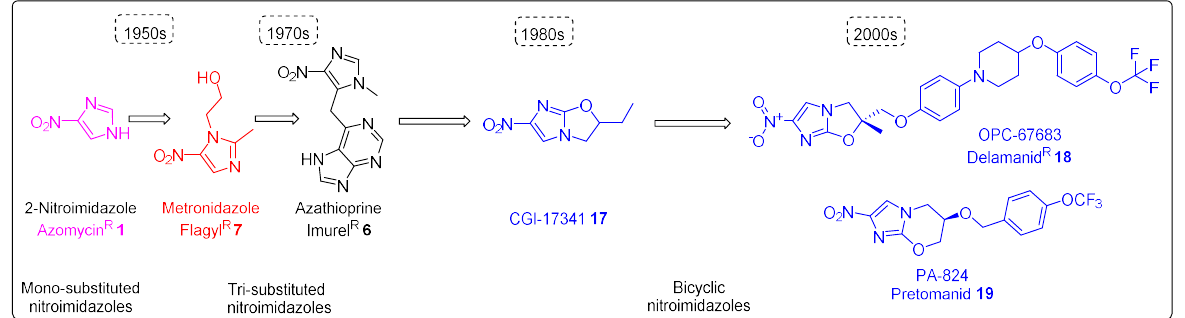
Figure 3. Transition from simple nitroimidazole to functionalized and optimized nitroimidazole-based drug candidates.